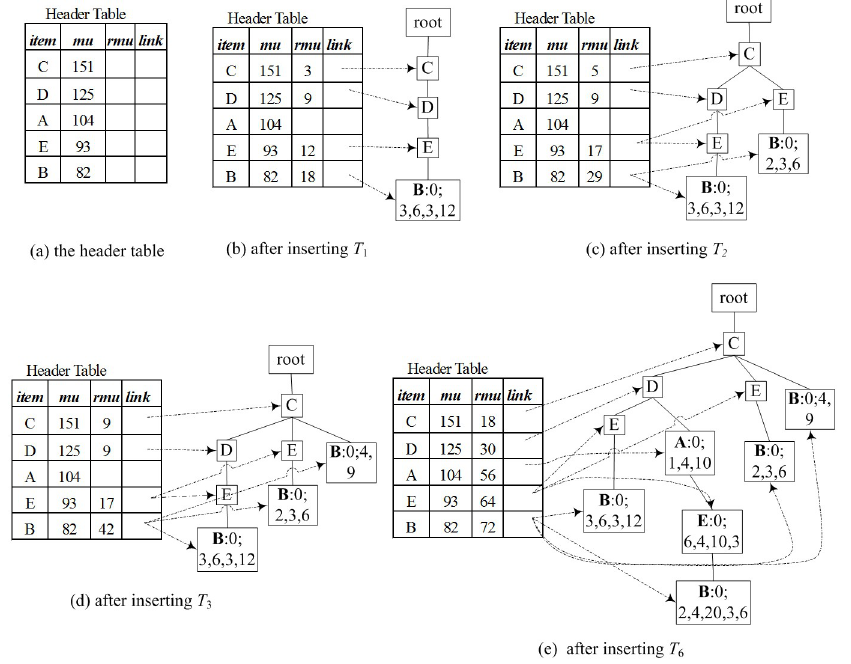
Fig 2. Construction of a